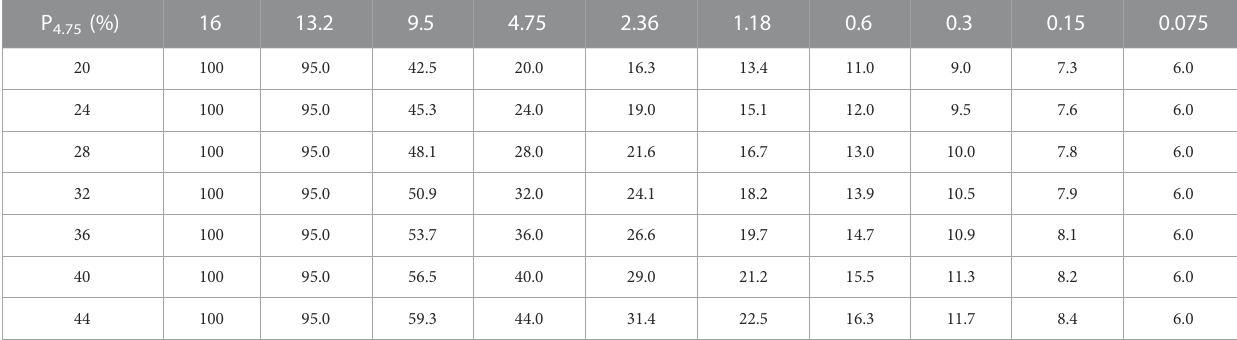
TABLE 7 Pass rates of gradations containing different contents of coarse